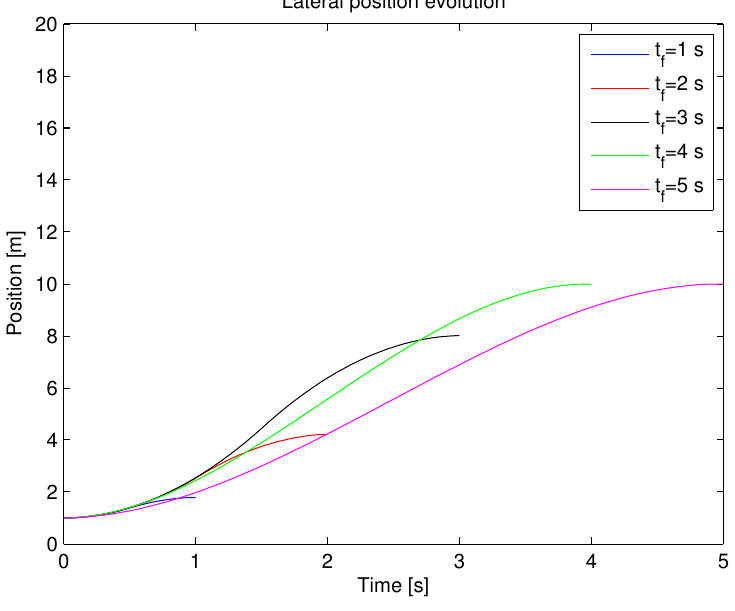
for different t D 1